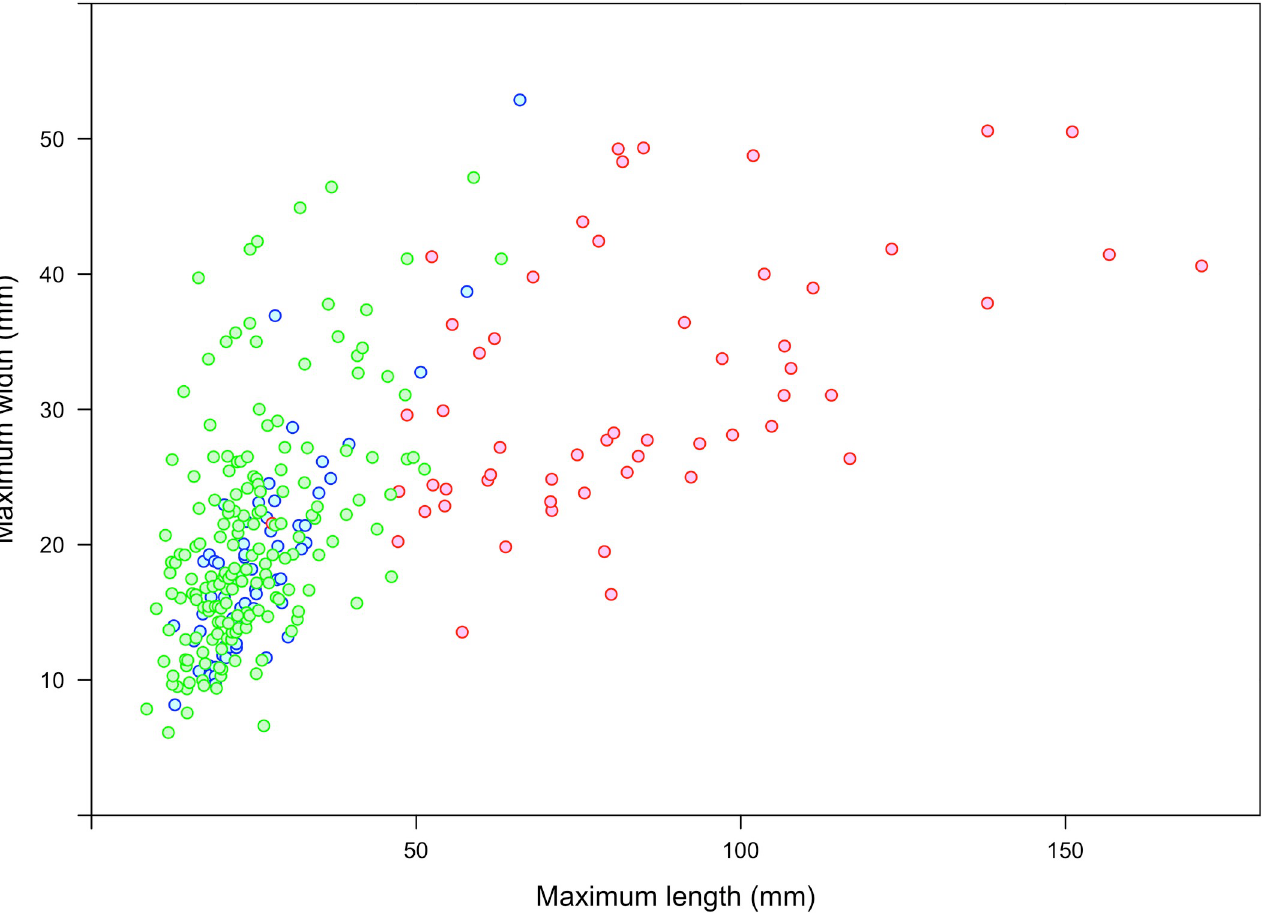
Fig 9. Morphometric comparison between the unretouched lithic flakes (green), lithic tools (blue) and expedient osseous tools (red) from Lingjing, layer 11. Data for the lithic remains extracted from [125, Fig 3].